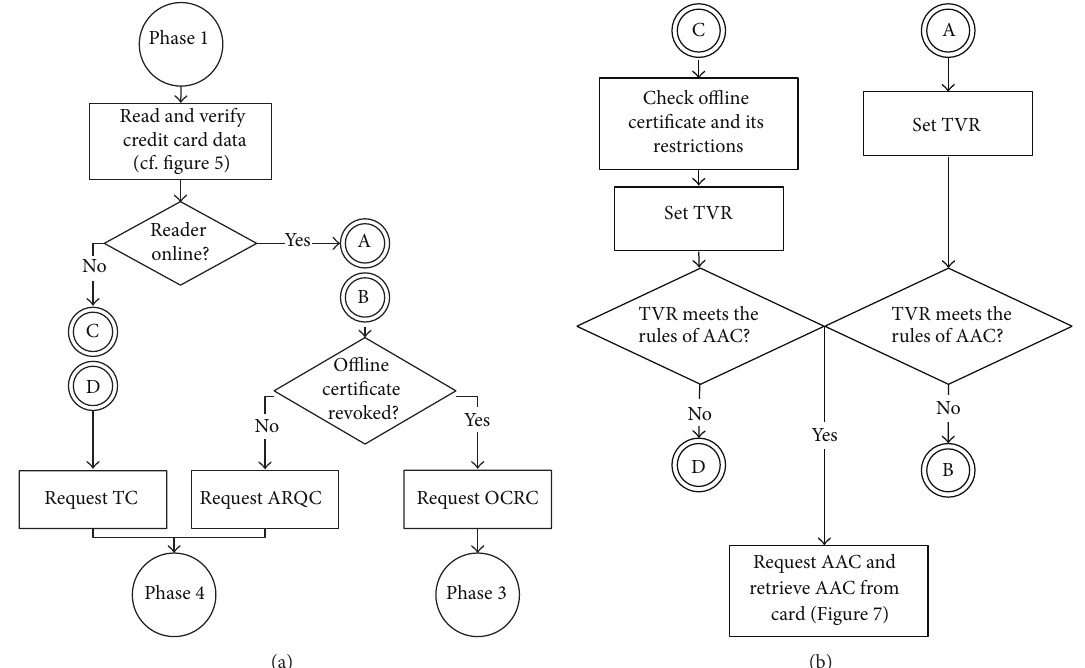
Figure 6: (a) Flow chart of online transaction/offline transaction/request for offline certificate. (b) Flow chart of refusal of